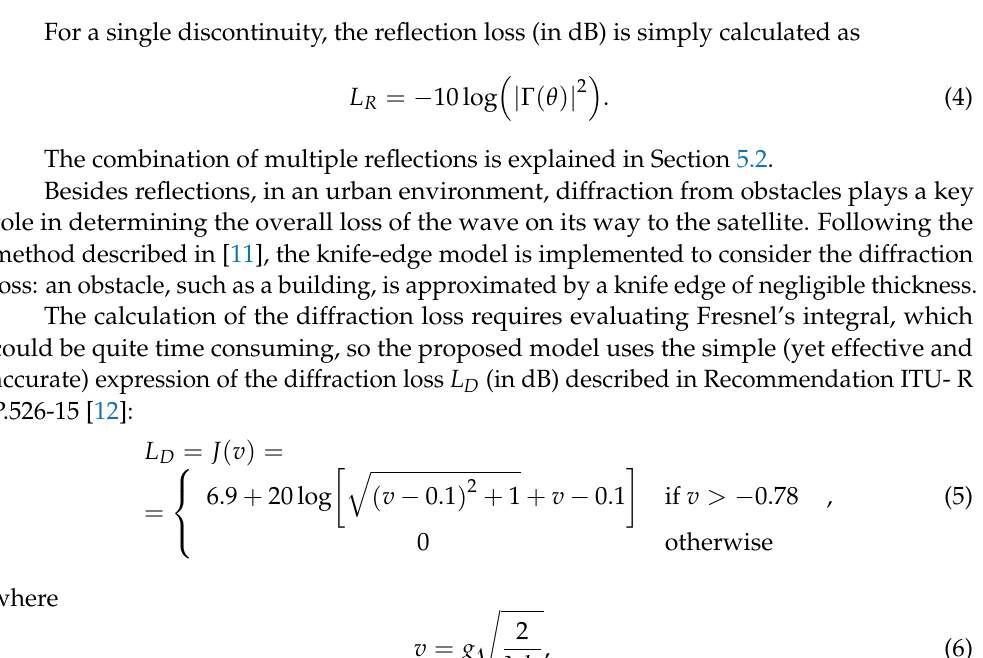
Figure 7. Trend of the absolute value of the reflection coefficient (both TE and TM cases) at 6 GHz as a function of the incidence angle, for different discontinuities: air to ground (asphalt) and building (concrete/brick wall and glass slab).